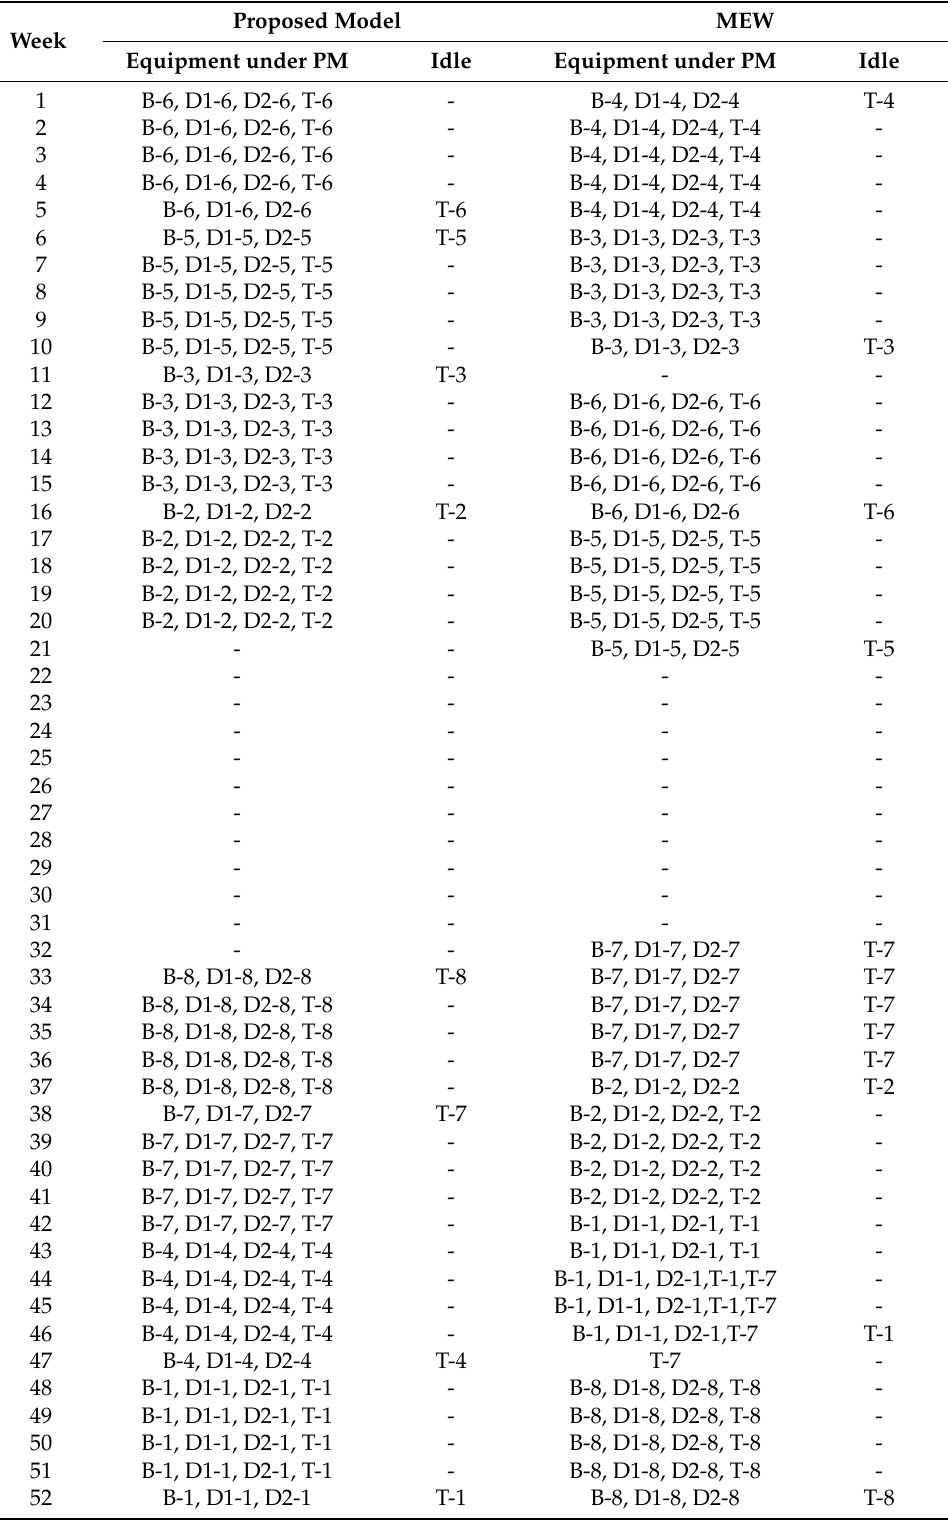
Table 1. PMS generated by the proposed model and by